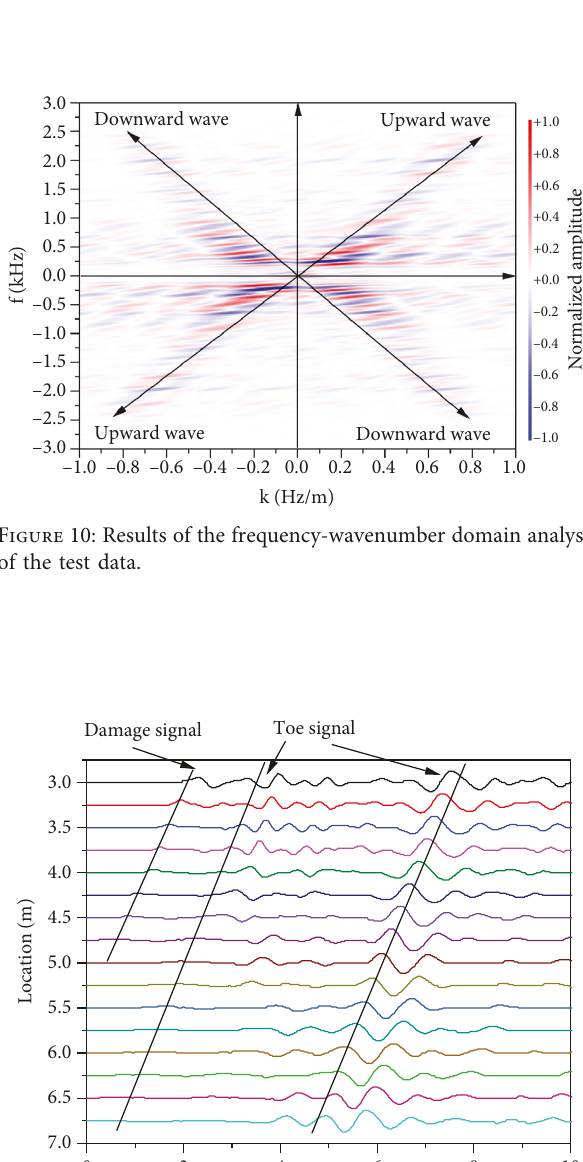
0.2m and z 3.0m. (b) The W velocity at y (cid:29) (cid:29)